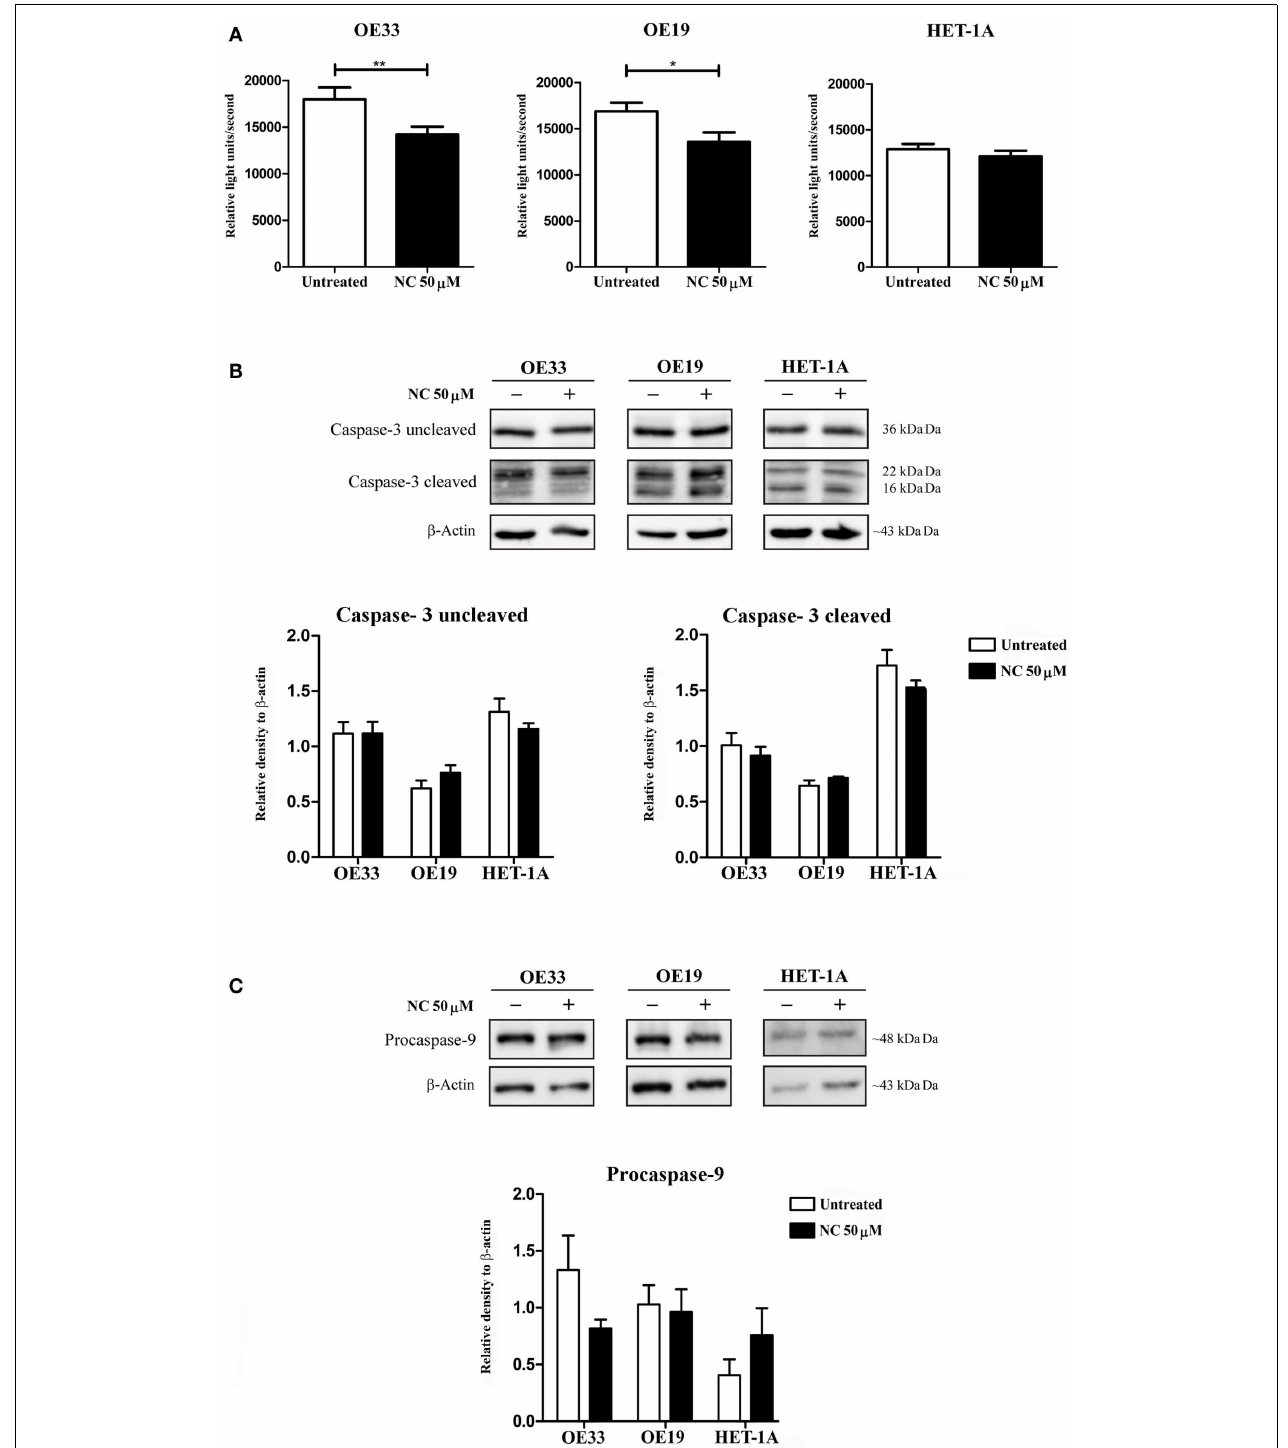
caspase-3 and procaspase-9 shows that treatment of the EAC cell lines OE33 and OE19 with 50 µ M nano-curcumin does not affect the levels of cleaved caspase-3 and procaspase-9.This is as well shown by densitometry data showing the ratio of cleaved caspase-3 and procaspase-9 to the loading control β -actin using Image J software (student’s two tailed paired t test, n = 3). Gels are representative of three independent